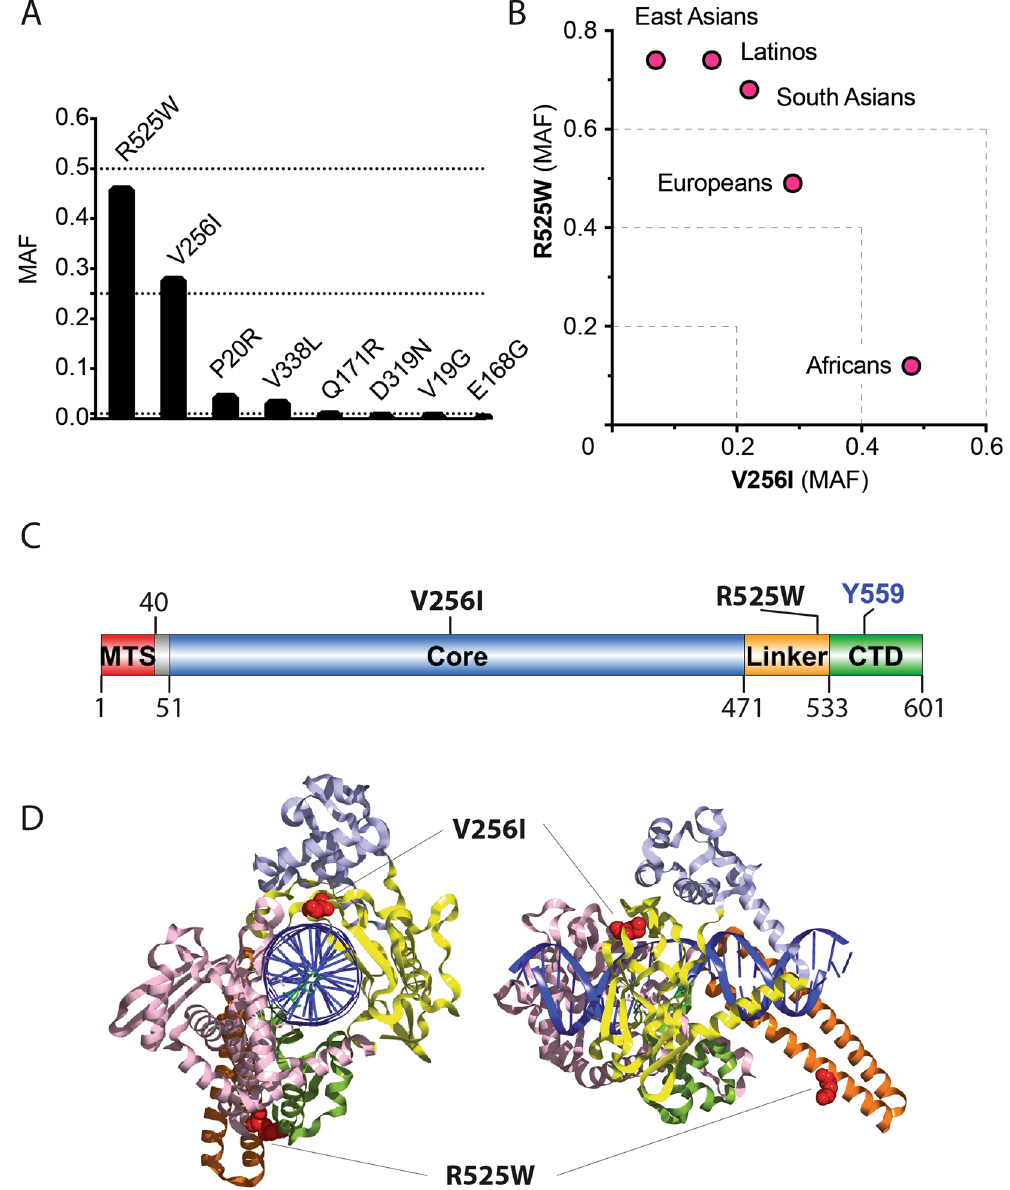
Figure 1. TOP1MT V256I and R525W variants. ( A ) Frequency of the TOP1MT variants in the overall human populations. ( B ) Relative distribution of the V256I and R525W variants across human ethnic groups. ( C ) Positions of the two variants relative to TOP1MT functional and structural domains in linear format. MTS: Mitochondrial Targeting Signal; Core: the core domain; Linker: the linker domain; CTD: C-Terminal Domain. ( D ) representation of the positions of the two variants based on the crystal structure of TOP1 31 (PDB ID: